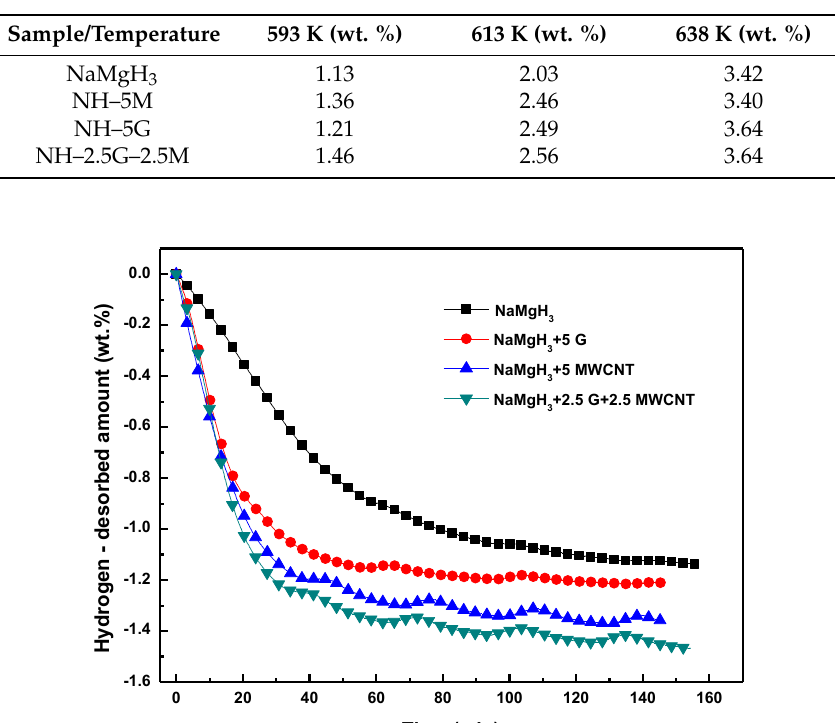
Figure 4. Dehydriding kinetic curves of the NaMgH 3 hydride and the NH-CM composites at 593 K.